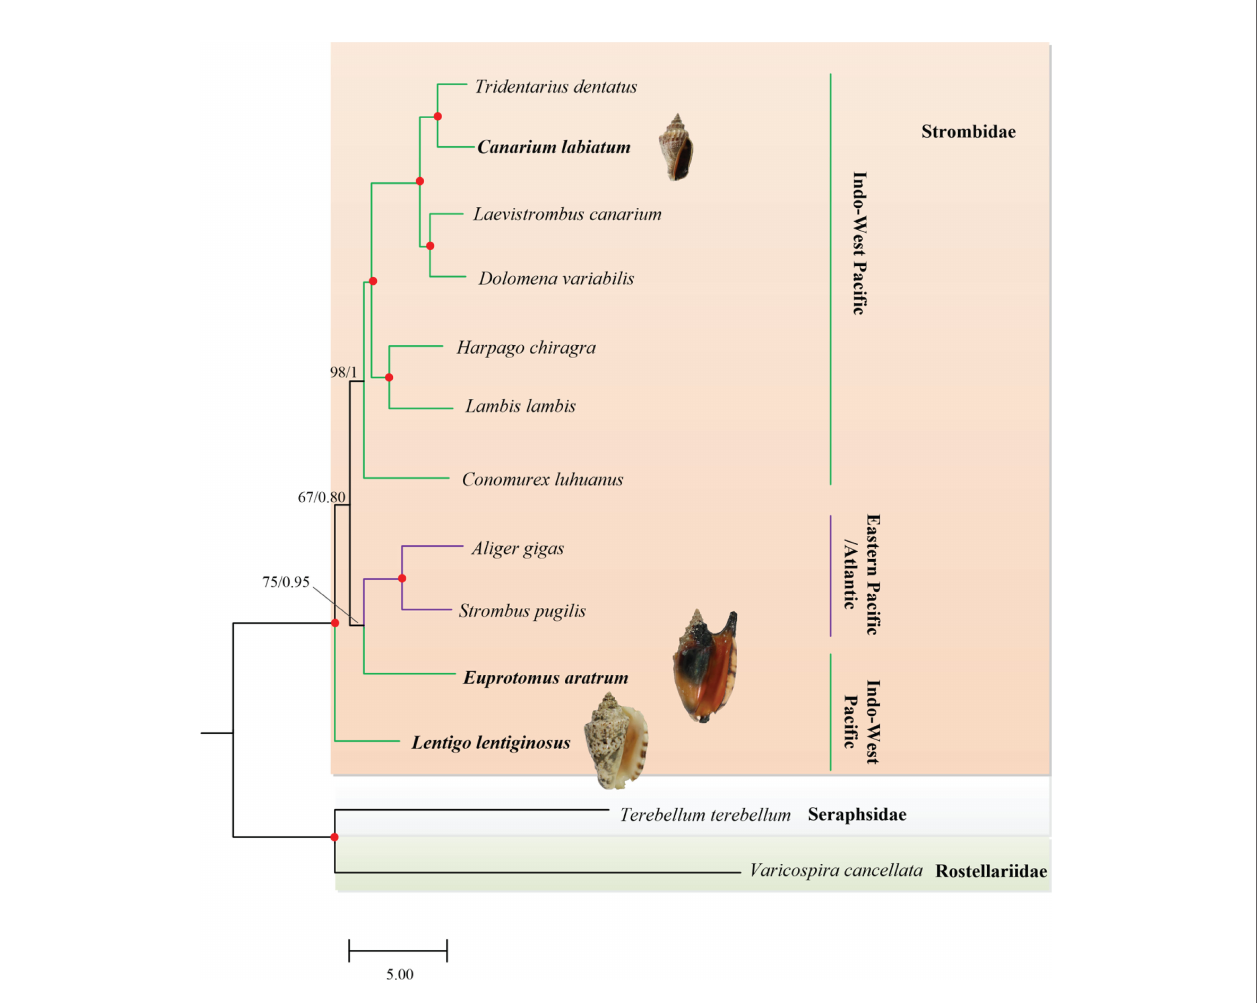
FIGURE 5 | Phylogenetic relationship of Strombidae based on nucleotide sequences of 13 mitochondrial protein-coding genes (PCGs) and 2 ribosomal RNA (rRNA) genes: the reconstructed maximum likelihood (ML) phylogram using Terebellum terebellum and Varicospira cancellata as outgroup is shown. The fi rst number at each node is bootstrap proportion (BP) of maximum likelihood (ML) analyses, and the second number is Bayesian posterior probability (PP). Nodal with maximum statistical support (BP = 100; PP = 1) is marked with a solid red circle. The branches in purple indicate Eastern Paci fi c/Atlantic strombids, while those in green represent Indo-Paci fi c